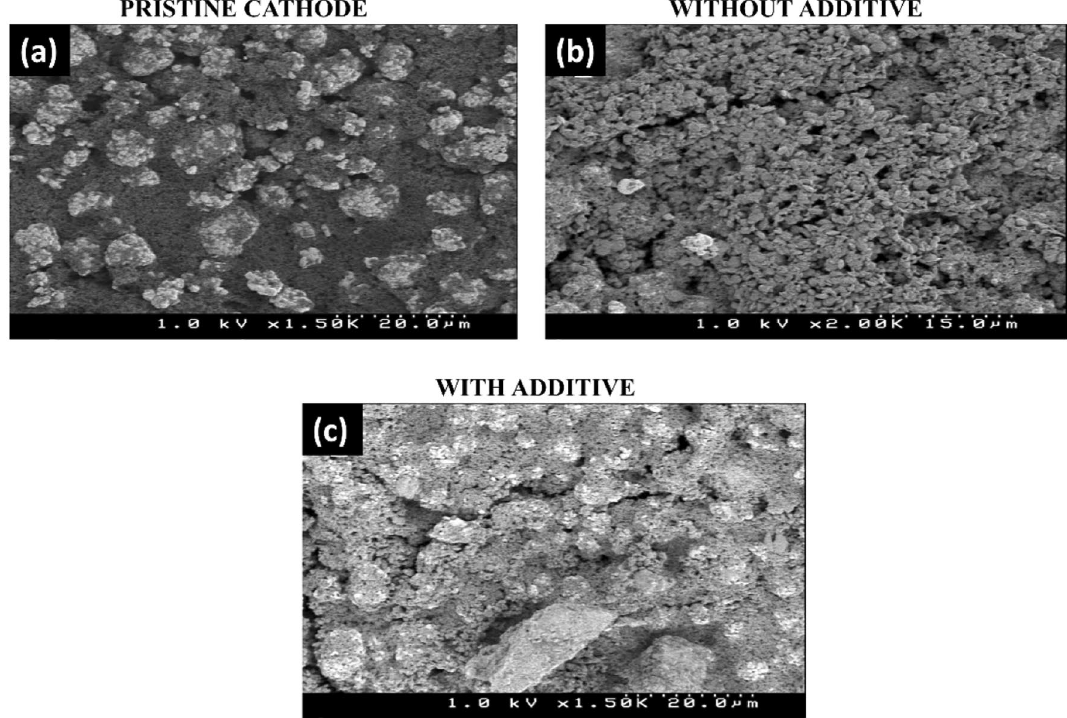
Figure 5. Study of surface morphology of LiNi 1/3 Mn 1/3 Co 1/3 O 2 cathodes upon storage in electrolyte. SEM micrographs of ( a ) pristine cathode, ( b ) cathode stored in electrolyte with no additive, and ( c ) cathode stored in electrolyte with DMBAP additive,